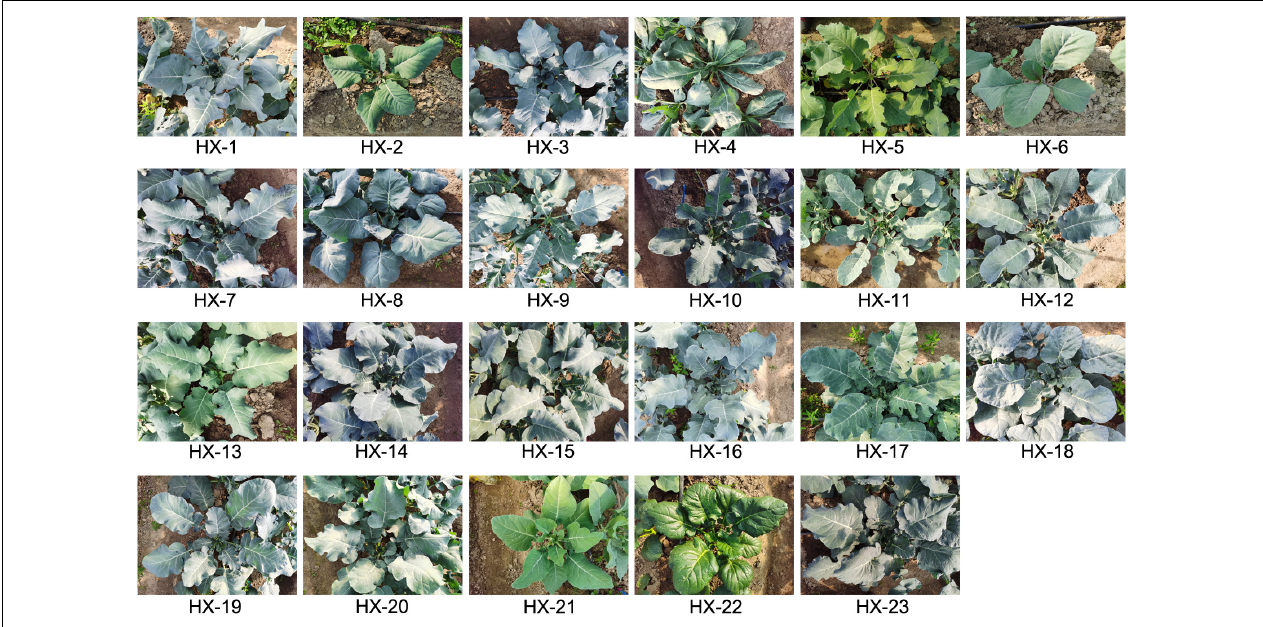
FIGURE 1 | Twenty-three diverse broccoli lines selected for whole-genome